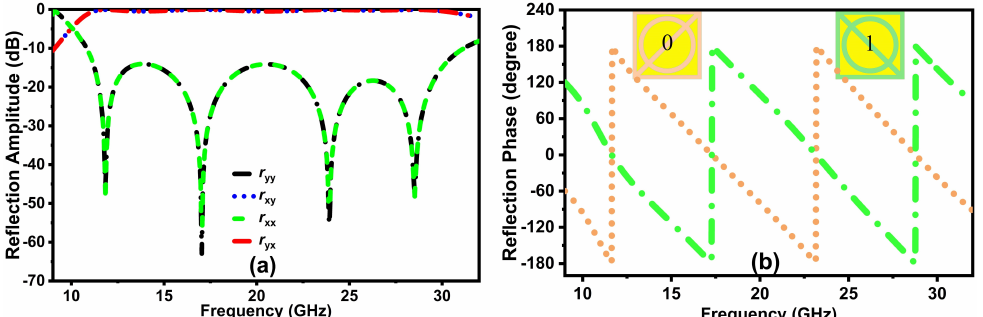
Figure 2. ( a ) Reflection amplitudes of meta-atom “0” under linear polarizations. ( b ) Cross-polarization reflection phases of meta-atom “0” and